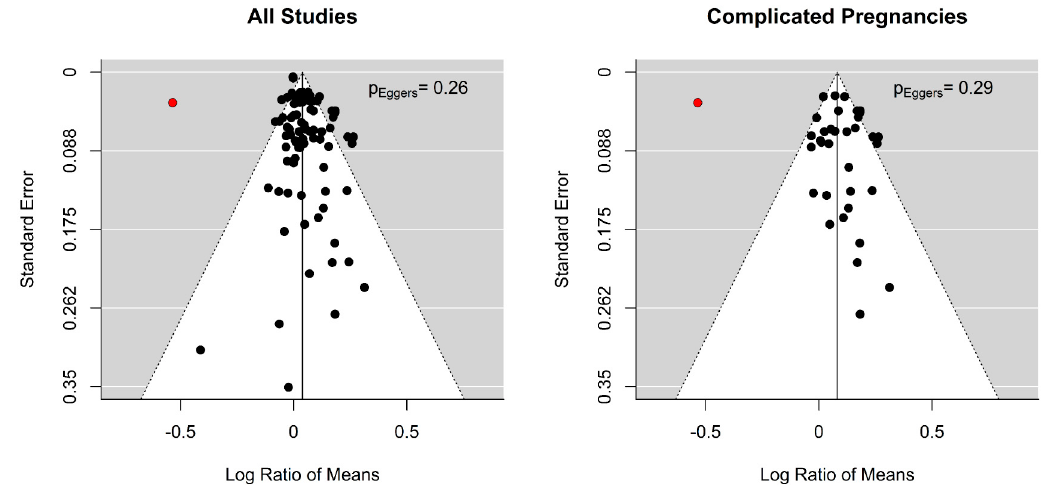
Figure A3. Funnel plot for amino acids of the arginine family and fetal/birth weight in all studies and in studies with only pregnancy complications. These funnel plots and Egger’s regression did not indicate publication bias in all studies or studies in complicated pregnancies. Black dots are the included studies. Sharkey et al., as an influential case, was highlighted by the colour red [51].